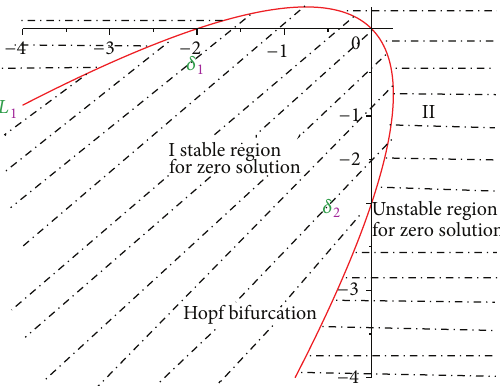
Figure 2: Bifurcation diagram on parameters 𝜇 1 and 𝜇 2 for the case of double zero and two negative